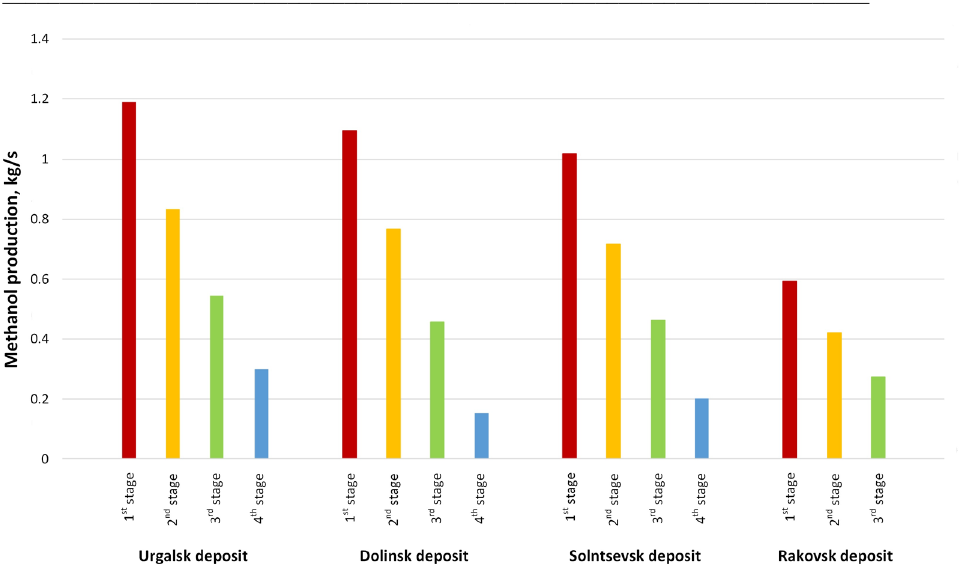
Fig. 2. The optimal number of synthesis